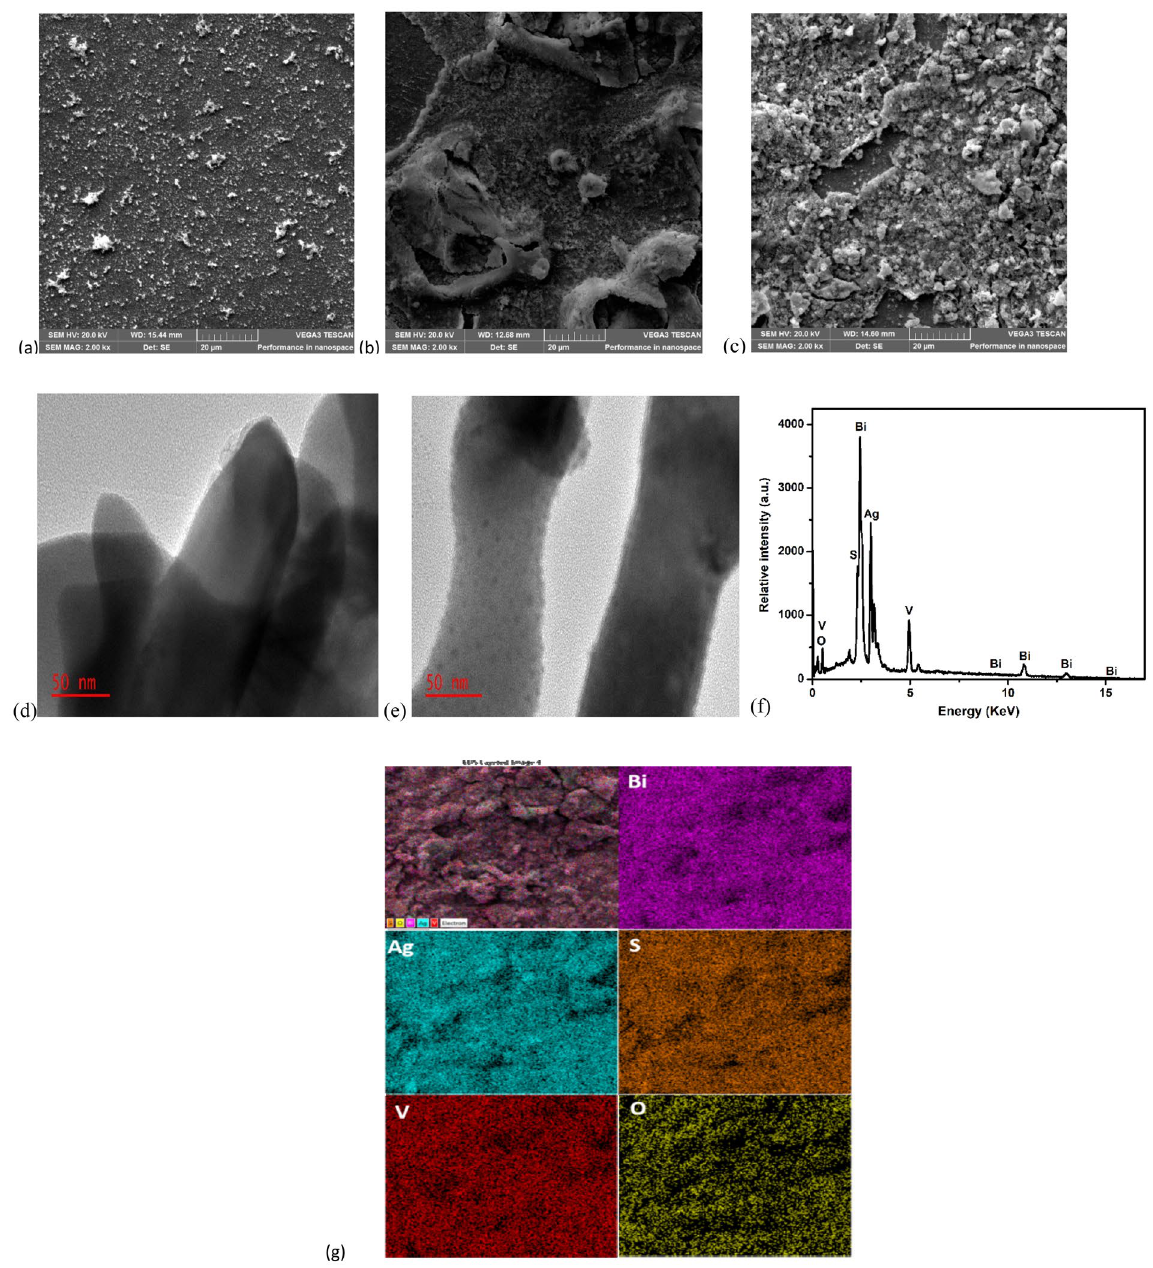
Figure 2. SEM images of ( a ) FTO-Ag 2 S; ( b ) FTO-BiVO 4 ; ( c ) FTO-BiVO 4 /Ag 2 S; HR-TEM images of ( d ) BiVO4; ( e ) BiVO4/Ag2S; ( f ) EDS spectrum of FTO-BiVO 4 /Ag 2 S and ( g ) EDS elemental mapping of FTO-BiVO 4 /Ag 2 S